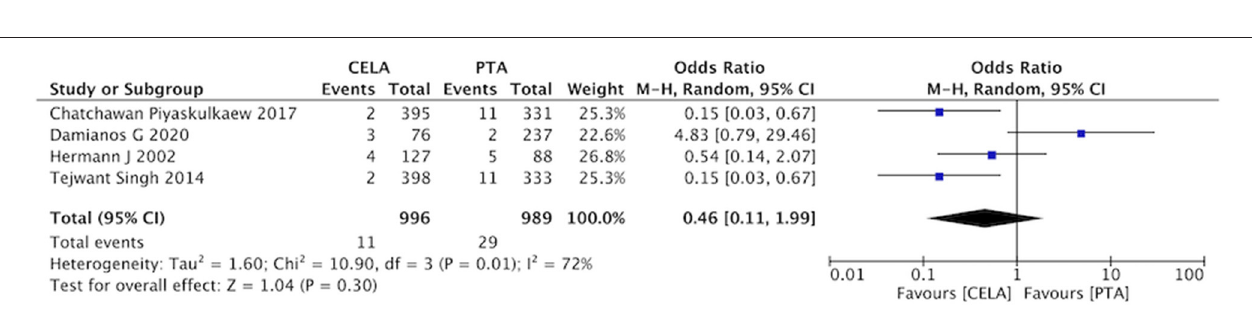
FIGURE 10 | Forest plot for embolization. Random, a randomized effects model; CI, confidence intervals. The blue squares stand for the weight of studies in meta-analysis. Black rhomboid represents the effects of combination of above four